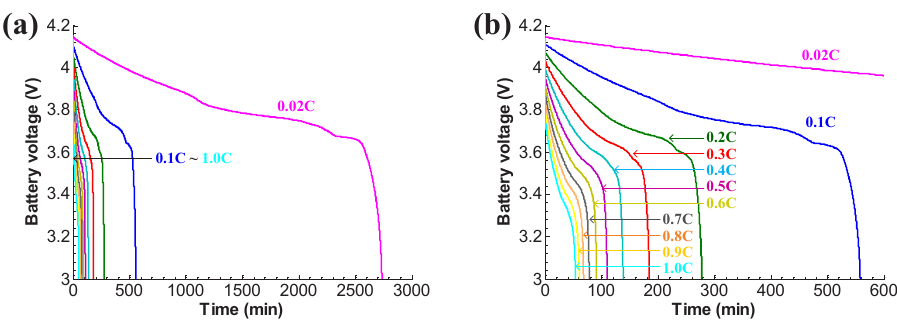
Figure 9. Battery voltage curves of the constant discharging current tests. Table 2. Measured runtime of the constant discharging current tests.